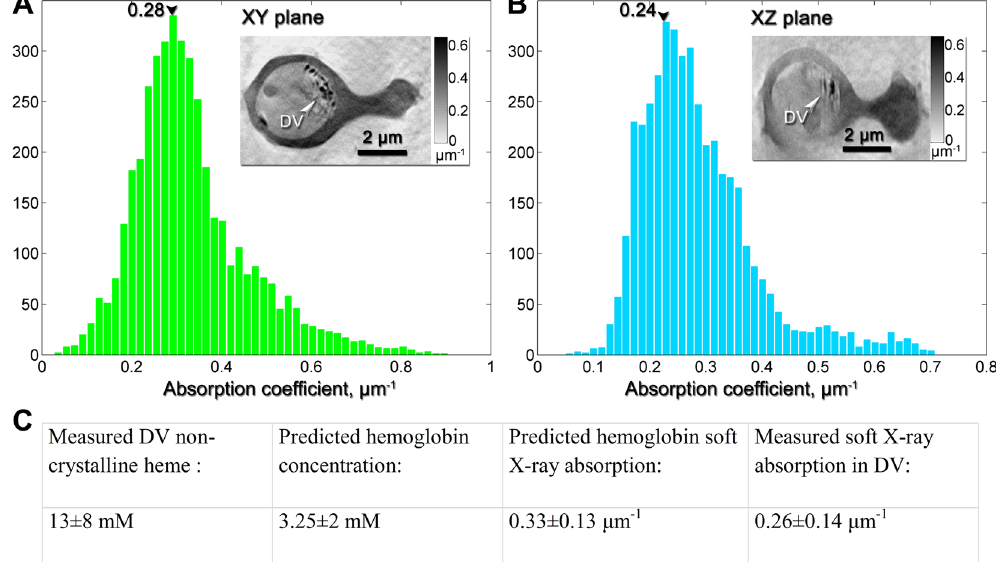
Figure 6. Measured X-ray linear absorption coefficients within the parasitic digestive vacuole, derived from the grey scale intensity contrast of the SXT data. ( A ) Absorption coefficient distribution in the digestive vacuole (DV) measured in a tomographic slice in the XY plane, which is parallel to the zero-tilt SXT projection, perpendicular to the optical axis Z and in a plane similar to that of the Fe fluorescence map. ( B ) Measurement in the XZ plane, which is parallel to the optical axis and perpendicular to the XY plane. Insets: corresponding grey scale images of the tomographic slices in the XY and XZ planes. The absorption coefficients are derived from the pixels within the digestive vacuole (DV). The histograms peak at 0.28 and 0.24 μ m − 1 , and the mean of